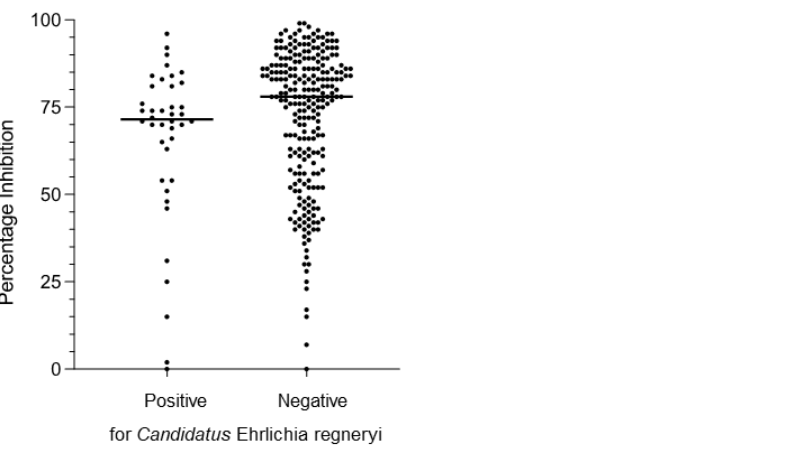
Figure 6. Comparison of PC-ELISA percentage inhibition (PI) values obtained from camels sampled in Marsabit County whose blood was PCR-positive ( n = 40) or PCR-negative ( n = 246) for Candidatus Ehrlichia regneryi [16]. Median PI value (widest horizontal line) for negative camels was significantly higher than that of positive camels. Data were analysed using a two-tailed Mann – Whitney test; * p = 0.03.